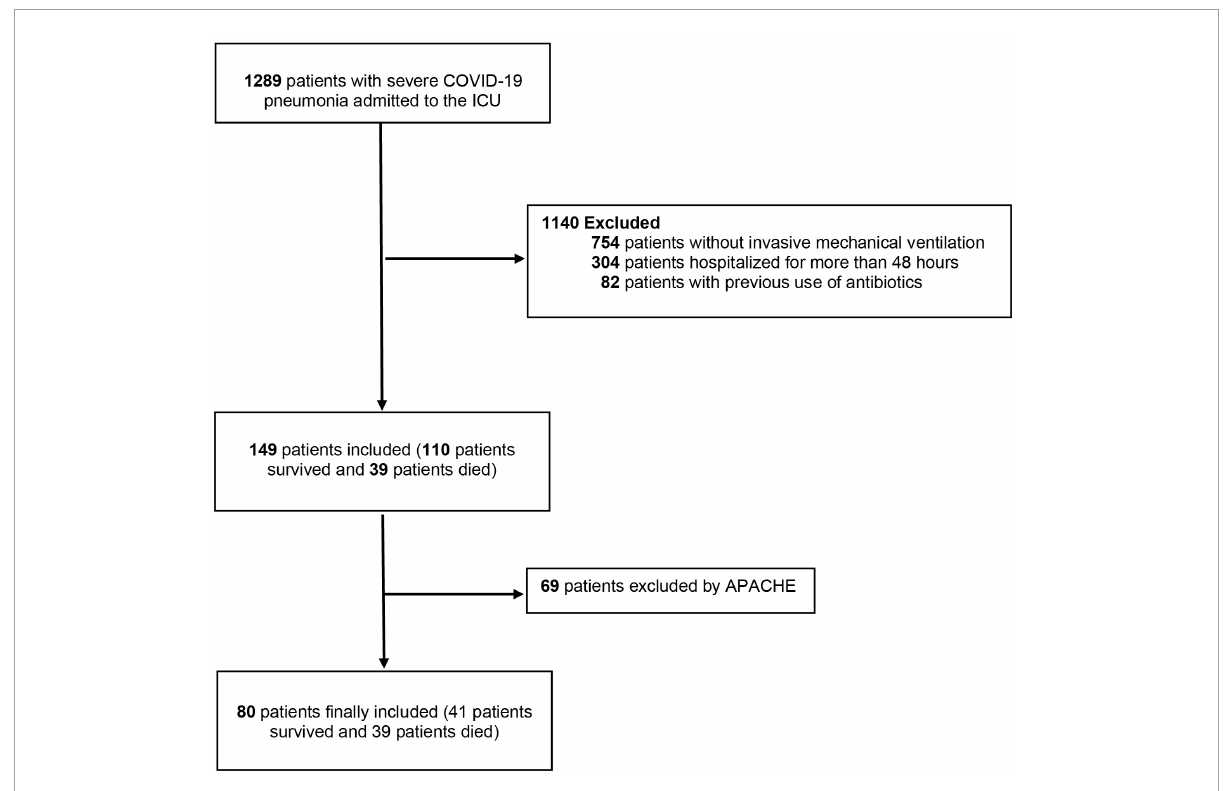
FIGURE1 Study flowchart. ICU, intensive care unit; APACHE, Acute Physiology and Chronic Health